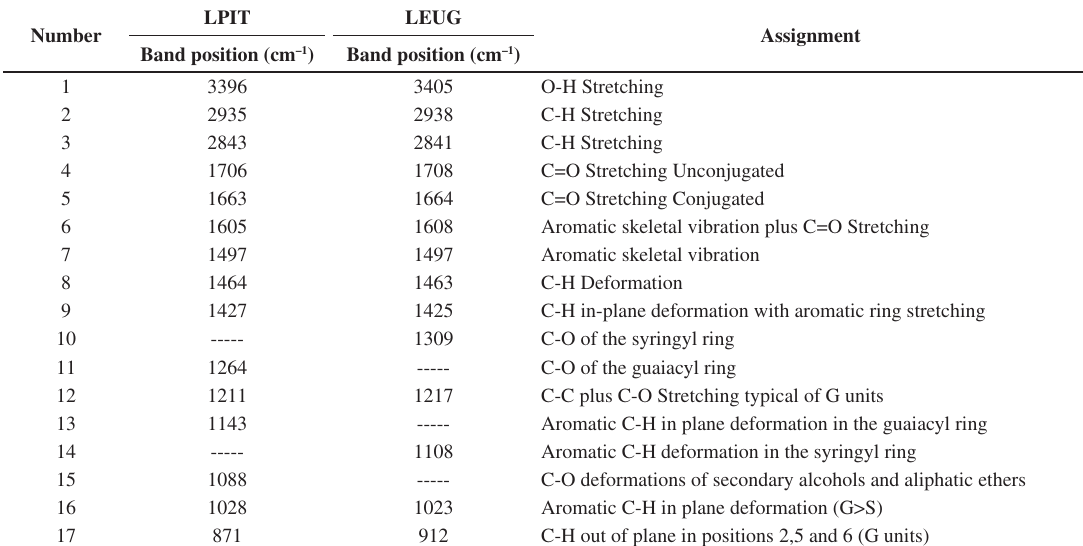
Table 3. Summary of the bands observed for the lignins studied.